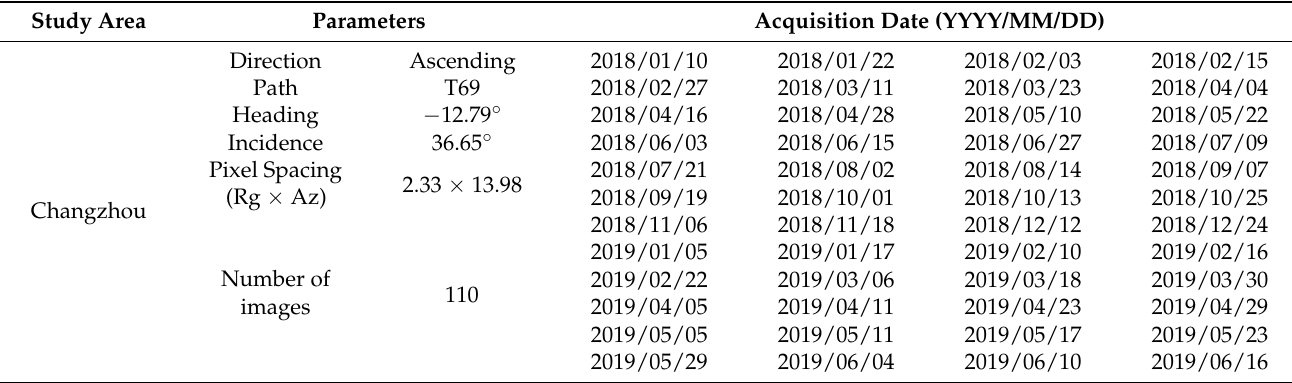
Table A1. Parameters of the images used in this